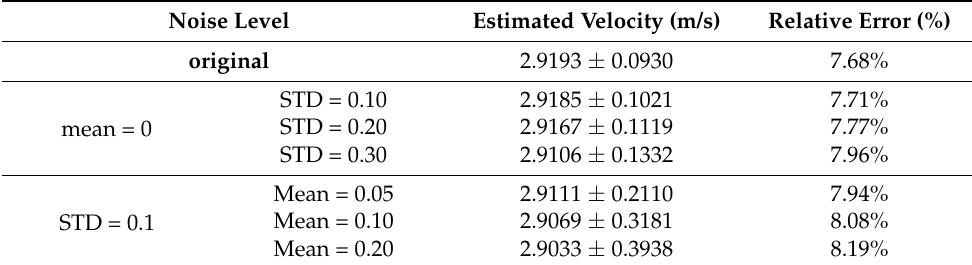
Figure 11. Shear wave velocity estimation with different mean noise. The mean is ( a ) 0.05, ( b ) 0.1, ( c ) 0.2. Table 4. Estimated shear wave velocity after adding